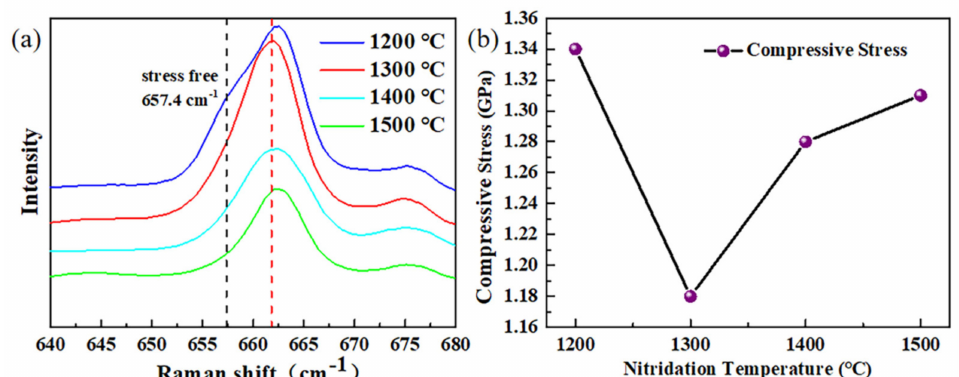
Figure 5. ( a ) Raman spectra for AlN samples grown at different nitridation temperatures. The blue, red, cyan and green curves correspond to 1200, 1300, 1400 and 1500 ◦ C, respectively. ( b ) The compressive stress of AlN film as a function of the nitridation